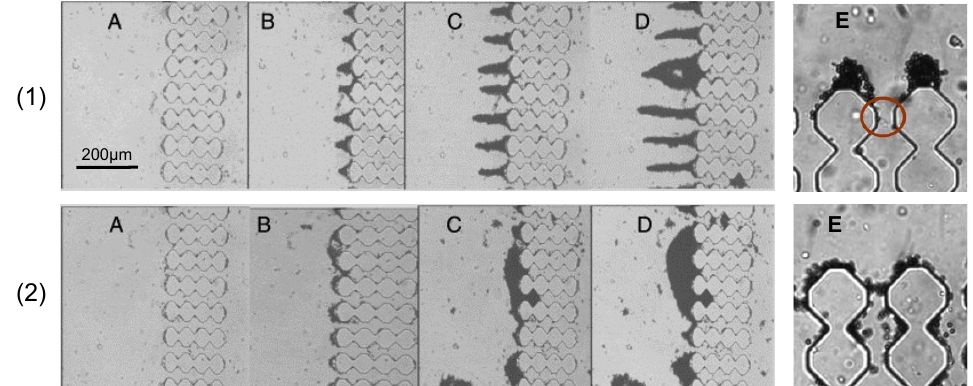
Figure 6. Observation of pore clogging caused by particle deposition over time (from ( A – D )). Two different behaviors can be identified based on PDMS surface properties. Row (1) shows pore blocking in hydrophilic conditions, where particles form dendrites at the pore entrances. Row (2) depicts clogging in hydrophobic conditions; here frequent particle collisions with the wall promote the formation of arches (onset E ) and the subsequent formation of a cake layer. Adapted from [59].